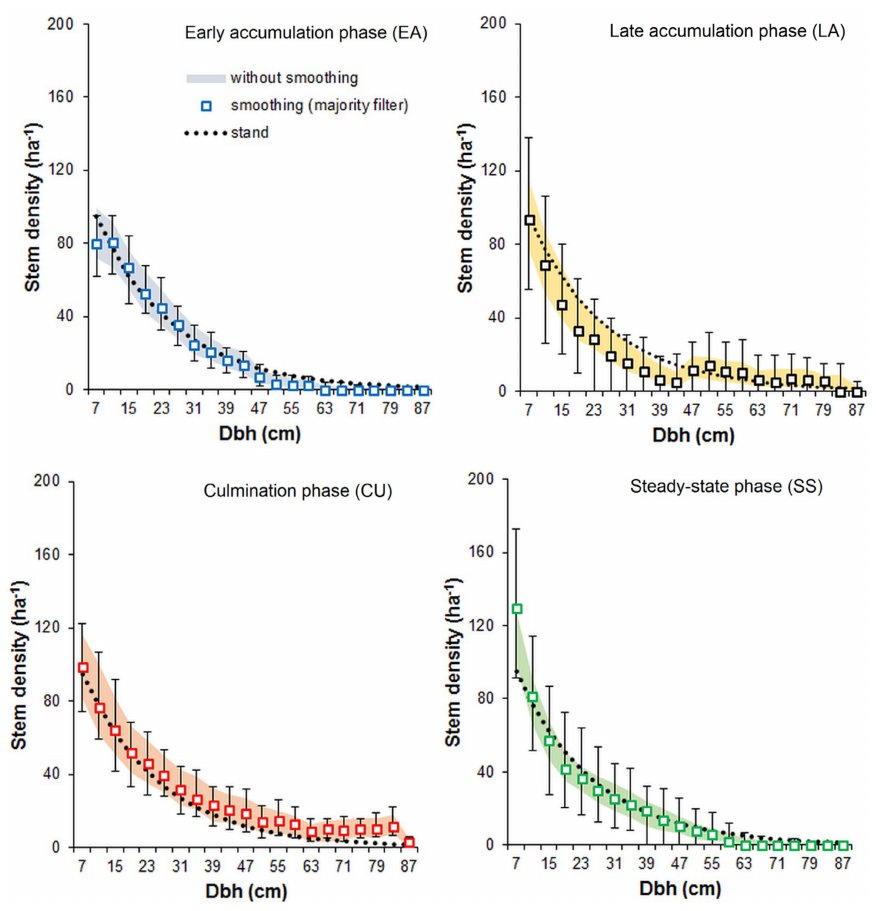
Figure 8. Simulation envelopes for tree counts in the dbh classes obtained for the original (shaded area, 5th and 95th percentiles) and filtered patterns (points—mean values, whiskers—5th and 95th percentiles) of the phase distribution. The dotted line shows the dbh distribution for the model stand. In the classification procedure, the moving window diameter was 15 m. For the noise smoothing, the majority filter with the kernel 5 × 5 cells was used.